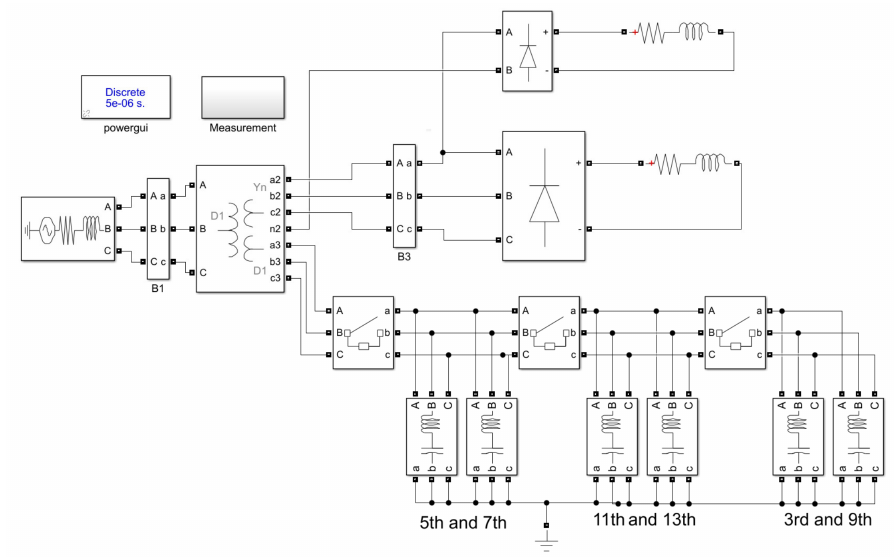
Figure 11. Schematic of the inductive filtering